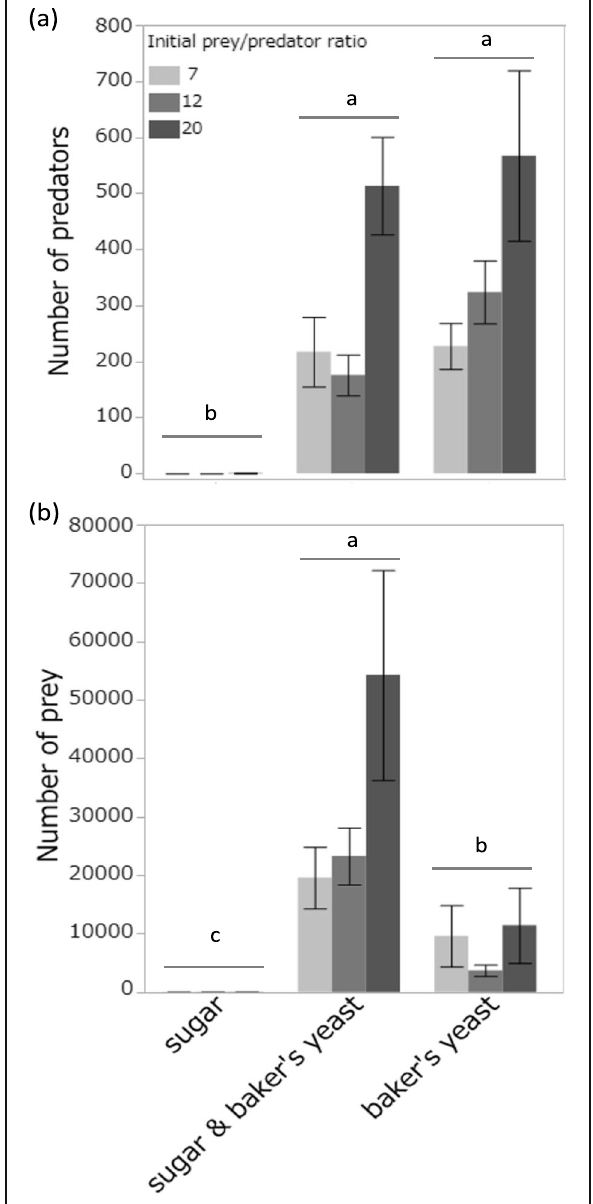
Fig. 2 Mean numbers (± SE) of a Predatory mites Amblyseius swirskii and b Prey mites Carpoglyphus lactis reared on different diets at different initial predator:prey ratios for a month (30 days). Same letters indicate that means are not significantly different ( P > 0.05)